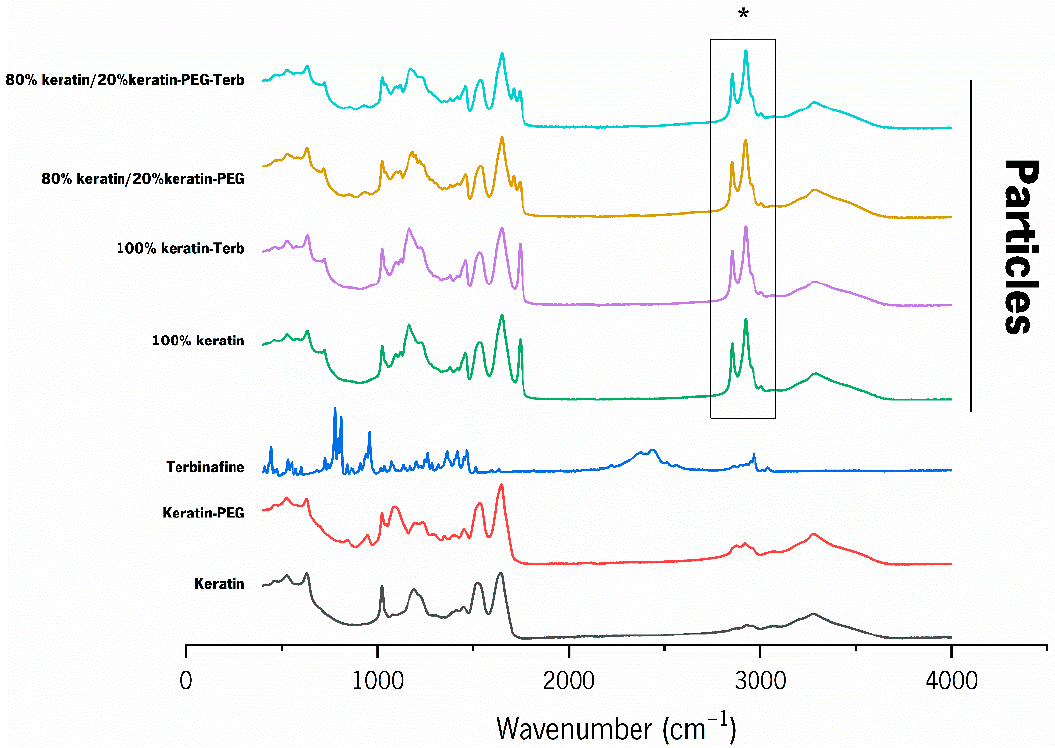
Figure 4. FTIR spectra of keratin, PEGylated keratin (Keratin-PEG), terbinafine and keratin particles (100% keratin; 100% keratin-Terb; 80% keratin/20% keratin-PEG; 80% keratin/20% keratin-PEG-Terb). * Corresponds to new peaks (2850 and 2920 cm − 1 ) after particles formation.